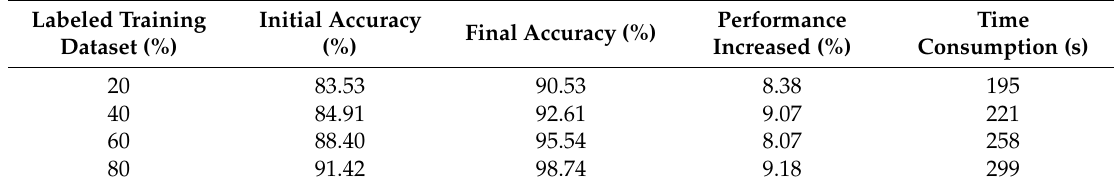
Table 5. Accuracy assessment of fall detection using a multi-features semi-supervised support vector machine